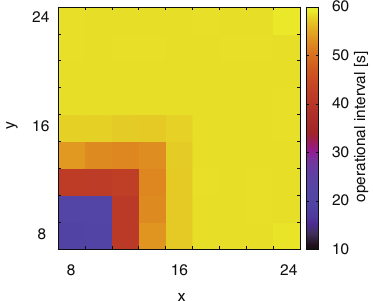
Figure 9. Operational interval in stepwise synchronization (Network 2).